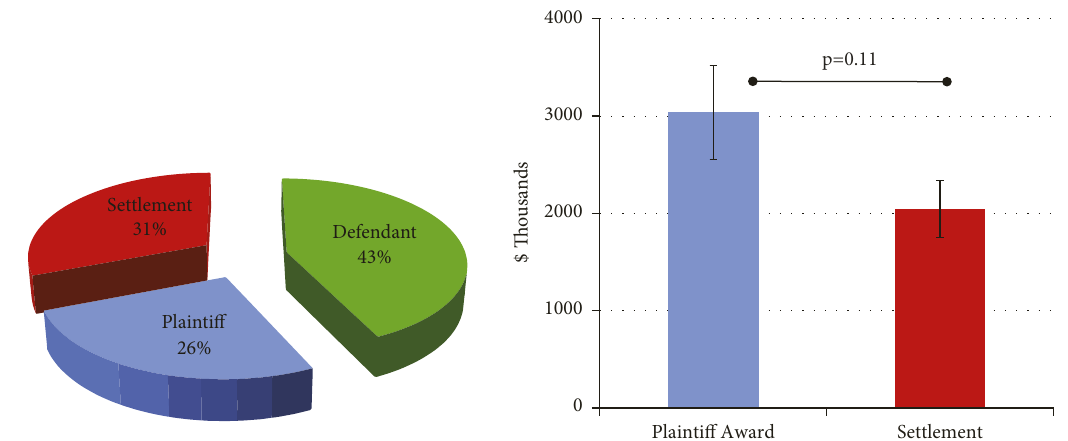
Figure 1: The consort diagram for the total cases reviewed.